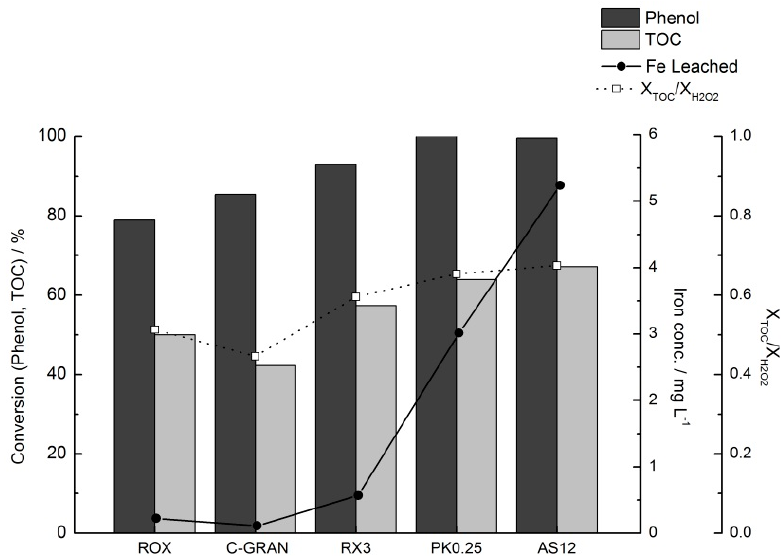
Figure 3. Conversions of phenol and total organic carbon (TOC) (respectively dark and light bars/left axis) and concentration of iron leached into solution, and X TOC /X H2O2 (respectively squares and circles/right axis), obtained after 24 h in CWPO runs performed under the conditions given in Figure 2.